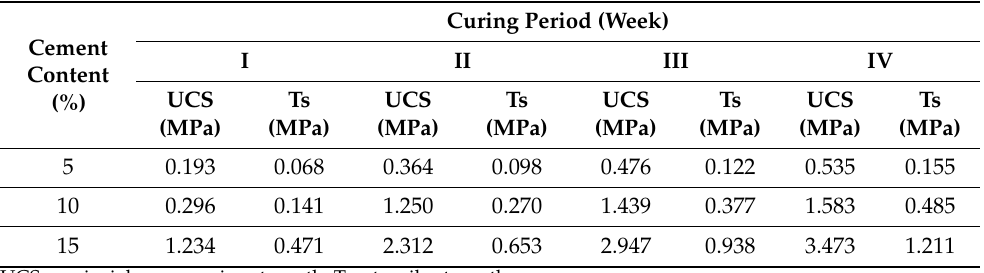
Table 1. Summary of the results of the strength tests (average values) of the cemented paste backfill.